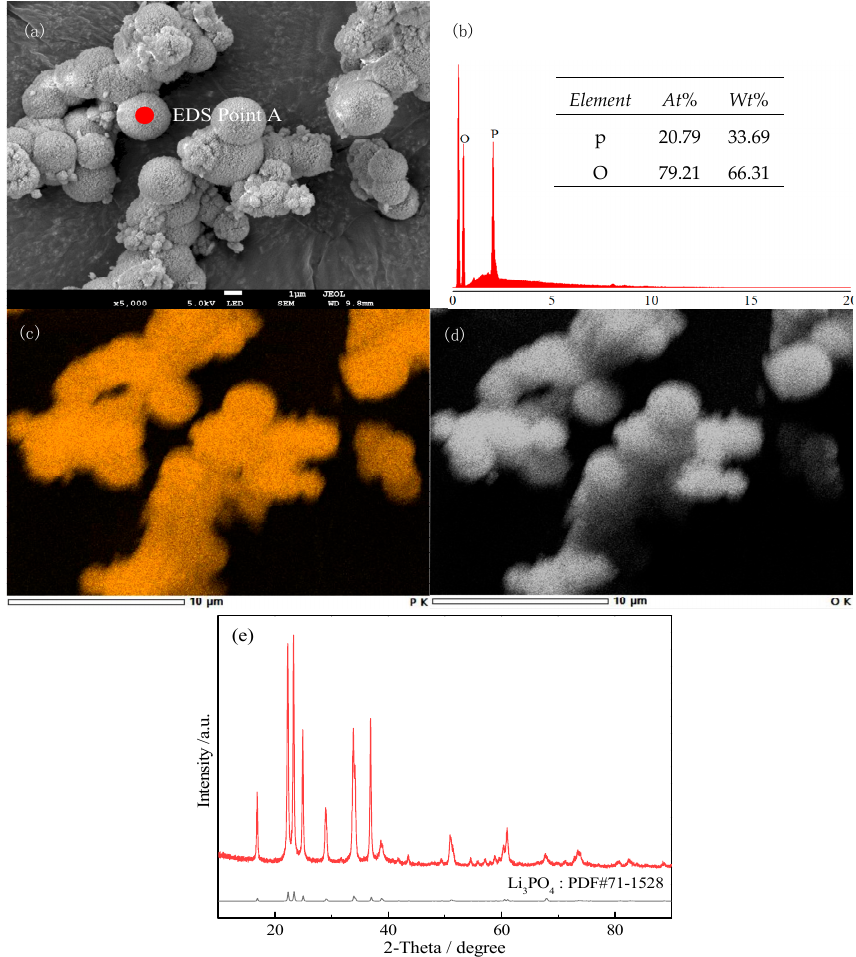
Figure 11. Characterization of phosphate precipitated lithium products: ( a ) electron micrograph of lithium phosphate; ( b ) EDS analysis of lithium phosphate A point; ( c ) phosphorus element distribution in lithium phosphate; ( d ) oxygen element distribution in lithium phosphate; and ( e ) XRD of the final lithium phosphate obtained under corresponding conditions (The conditions are: 200 r ∙ min − 1 , 70 °C, 1.5 h, PH = 8, n (actual dosage of Na 3 PO 4 ): n (theoretical dosage of Na 3 PO 4 ) = 1.2:1).